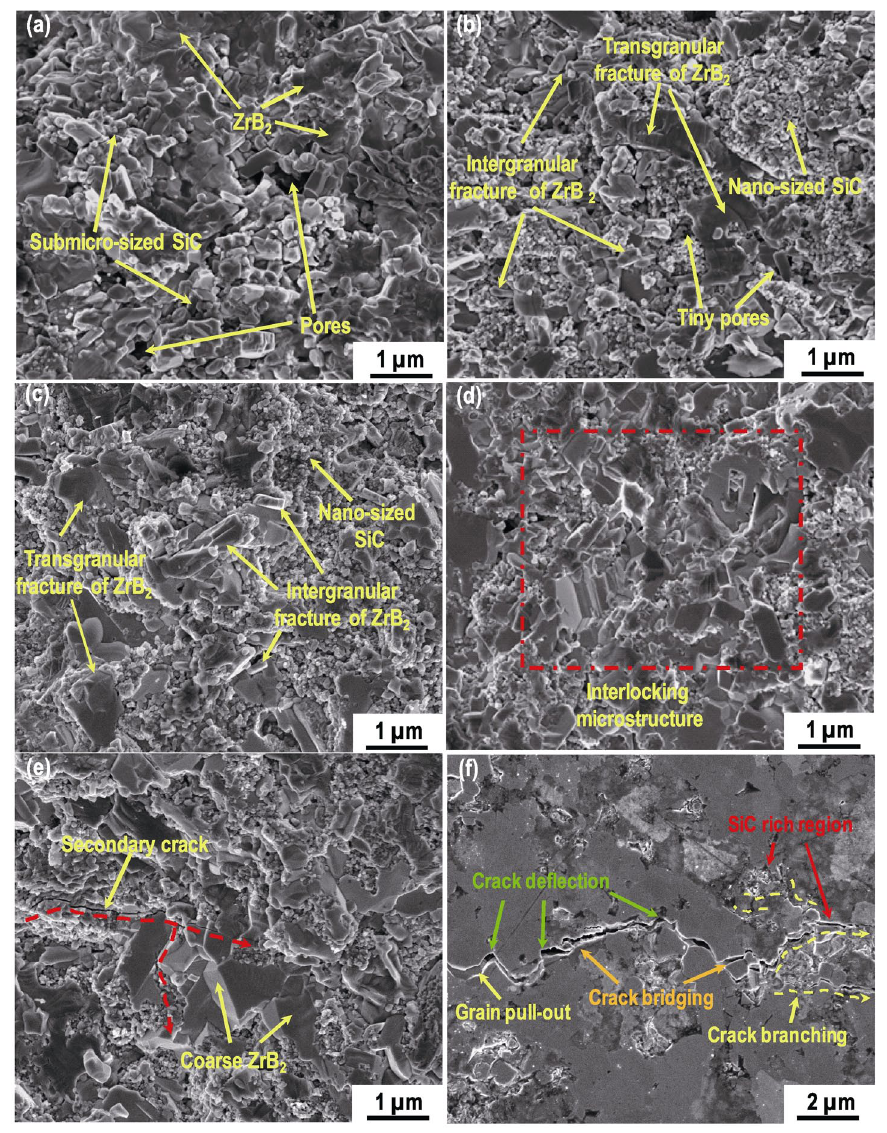
Fig. 8 Typical fracture surfaces of the ZrB 2 –SiC based composites prepared by reactive hot pressing: (a) RZSZ-0, (b) RZSZ-10, (c) RZSZ-15, (d) RZSZ-20, (e) RZSZ-25, and (f) SEM image of indentation crack propagation on the polished surface of